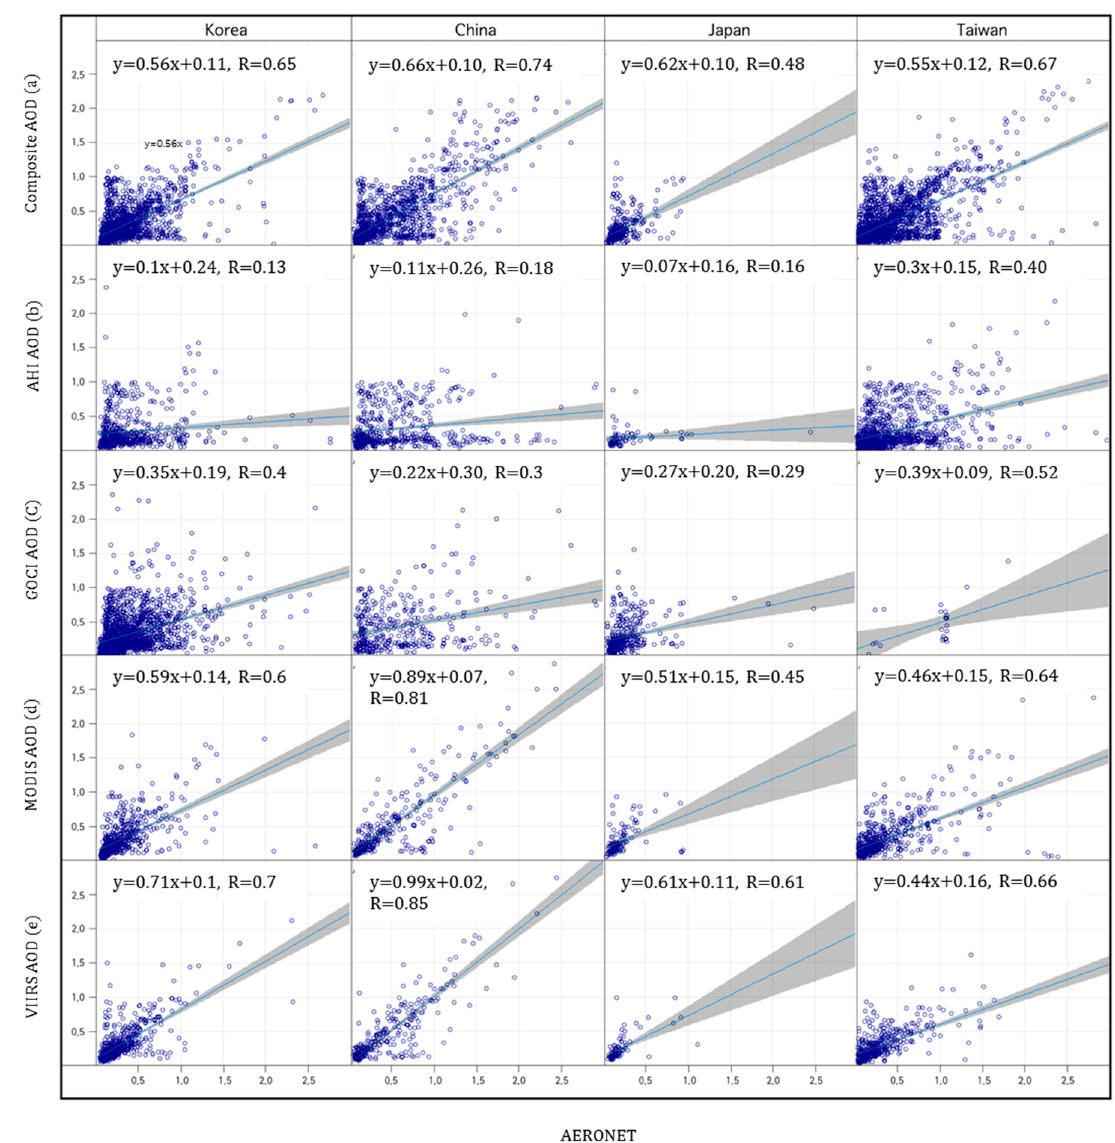
Figure A2. Regional comparison between AERONET and satellite AOD values for 2017: ( a ) Composite, ( b ) Himawari-8/AHI, ( c ) COMS/GOCI, ( d ) Aqua Terra/MODIS, and ( e ) Suomi-NPP/VIIRS. Blue line is the linear regression fit, and gray shading shows the associated error range. Table A1. Summary coefficients of Himawari-8/AHI AOD products during 2016 in training data ( X = AOD ). AERONET Sites